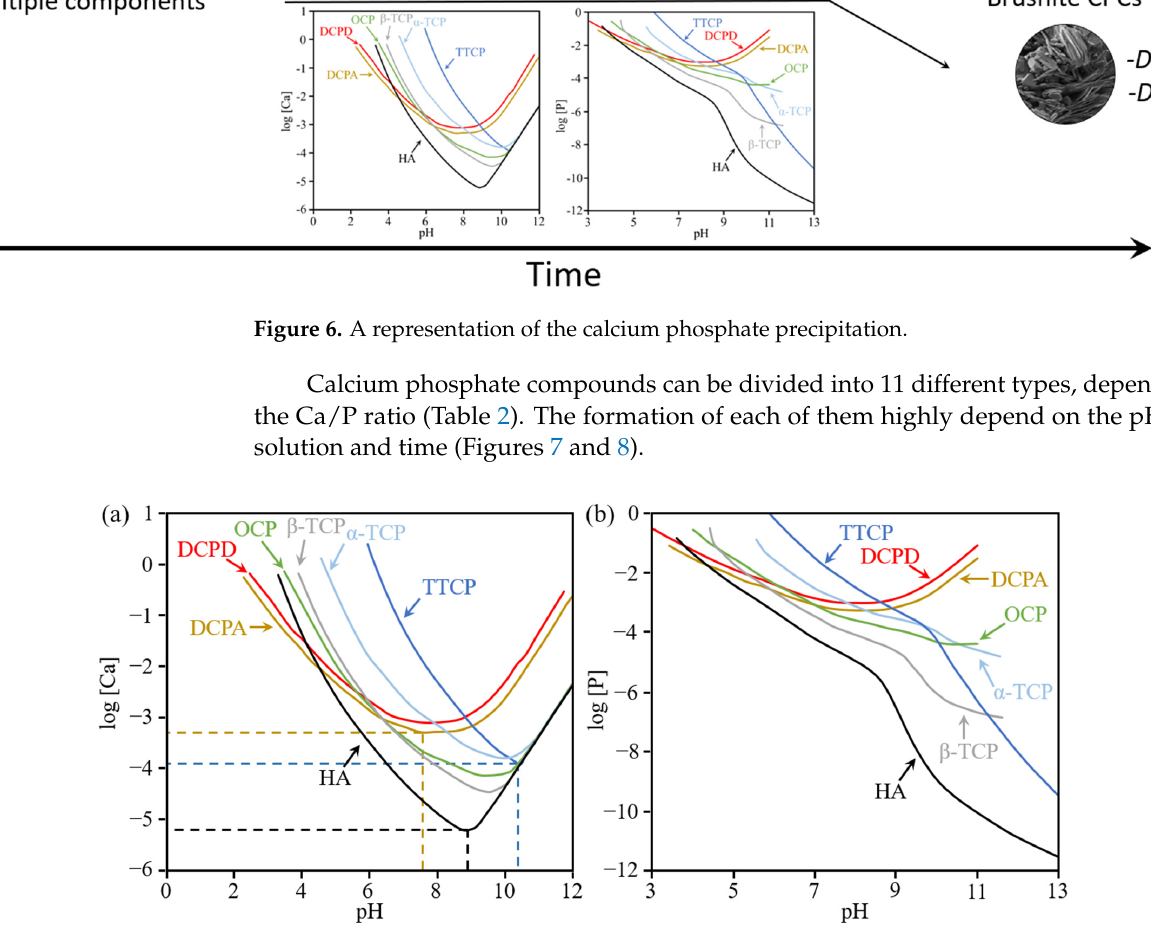
Figure 7. The solubility of the calcium phosphate compounds as a function of the Ca ( a ) and P ( b ) concentration dependence on pH [87,93].